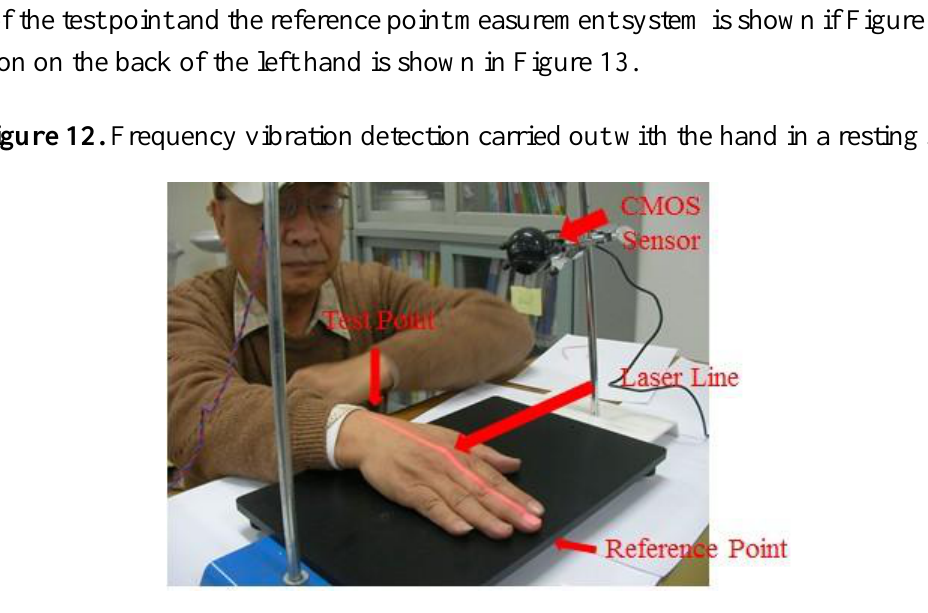
Figure 13. View the laser line at left hand of Parkinson's disease from the CMOS Image